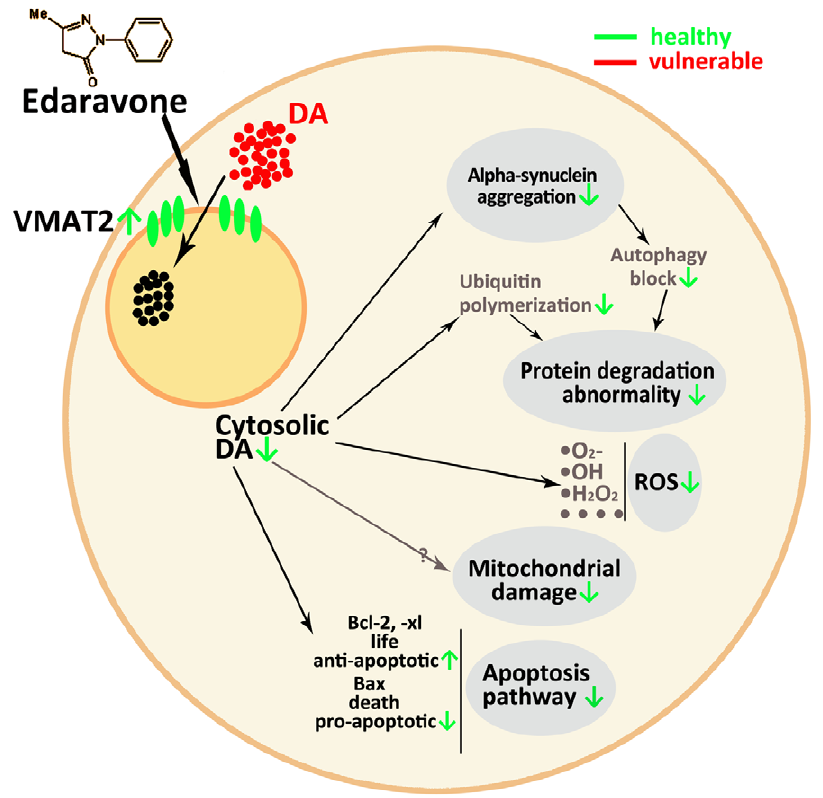
Figure 8. Working model for protective effect of edaravone on DA neurons. Up-regulation of VMAT2 expression by edaravone treatments to reduce cytosolic dopamine concentration, along with down-regulation of apoptosis pathways, may make DA neurons